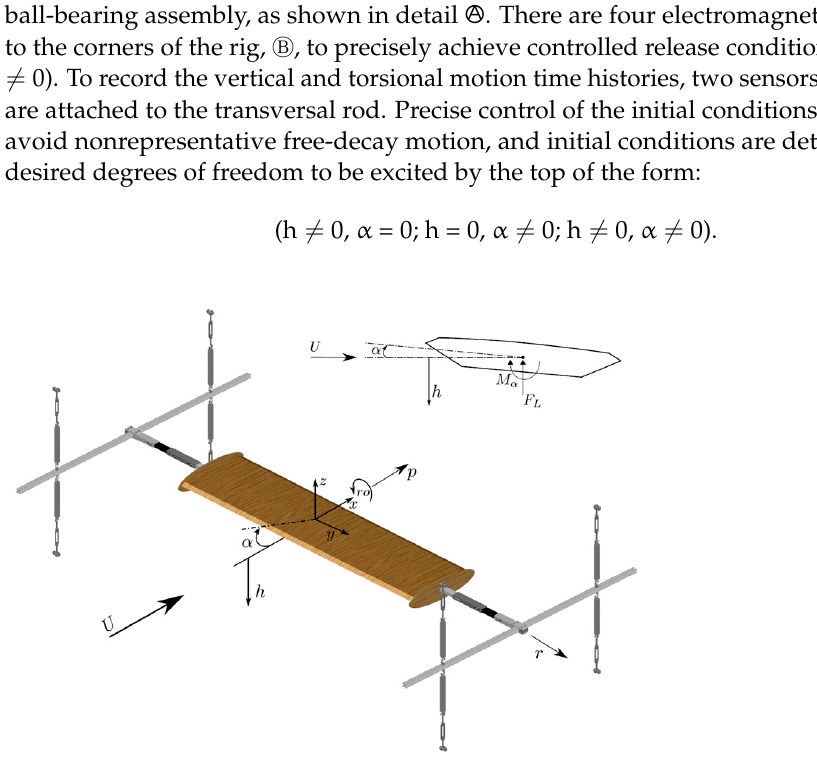
Figure 8. Three-dimensional model of test setup arrangement.